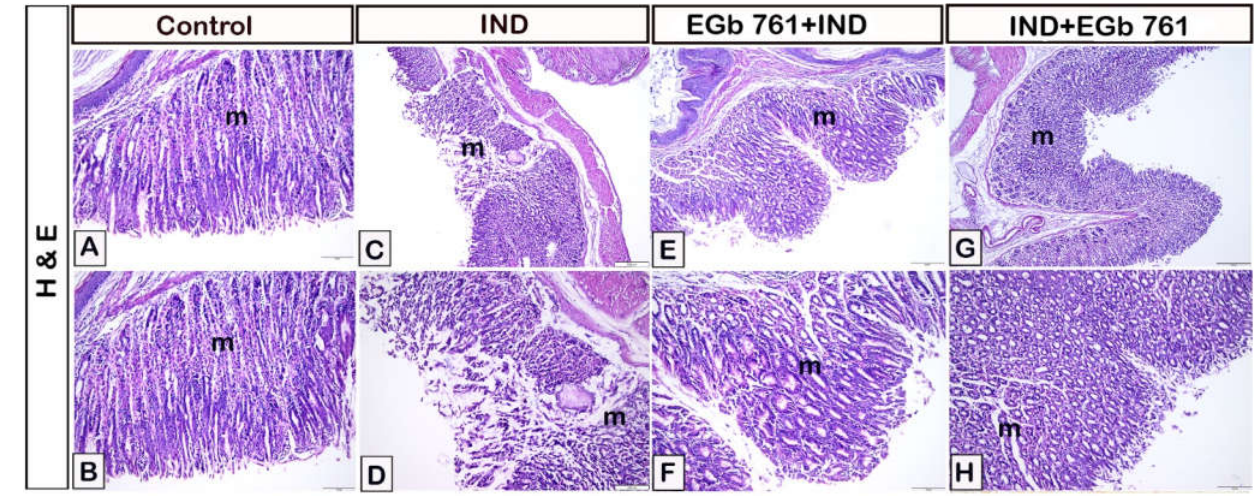
Figure 4. Gastric mucosal representative micrographs stained by hematoxylin and eosin. Effect of EGb 761 administration on the indomethacin-induced gastric ulcer. ( A , B ): Normal gastric mucosa in control mice. ( C , D ): Indomethacin-induced gastric ulceration (m) (IND). ( E , F ): EGb 761-pre-treated mice (Prophylactic EGb 761). ( G , H ): EGb 761 treatment after indomethacin (Therapeutic EGb 761). IND: Indomethacin; EGb 761: Standardized G. biloba extract. Table 1. Effect of EGb 761 on gastric tissue histomorphology of indomethacin-induced gastric ulcer. Lesions Histopathological